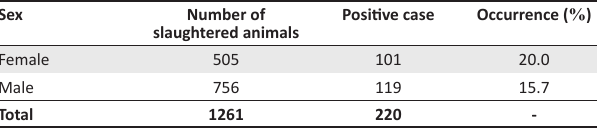
TABLE 3: Occurrence of foreign bodies according to gender.